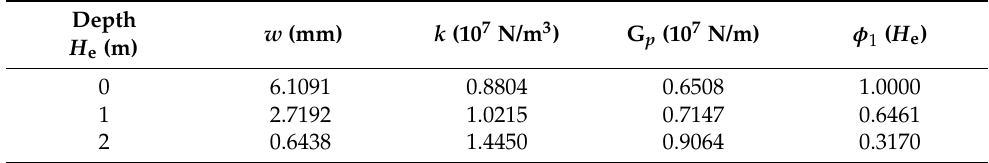
Table 2. Results for a beam embedded in a Gibson elastic foundation ( η 1 = 0.5). Depth